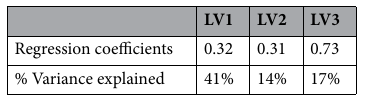
Table 3. PLSR summary. R 2 =